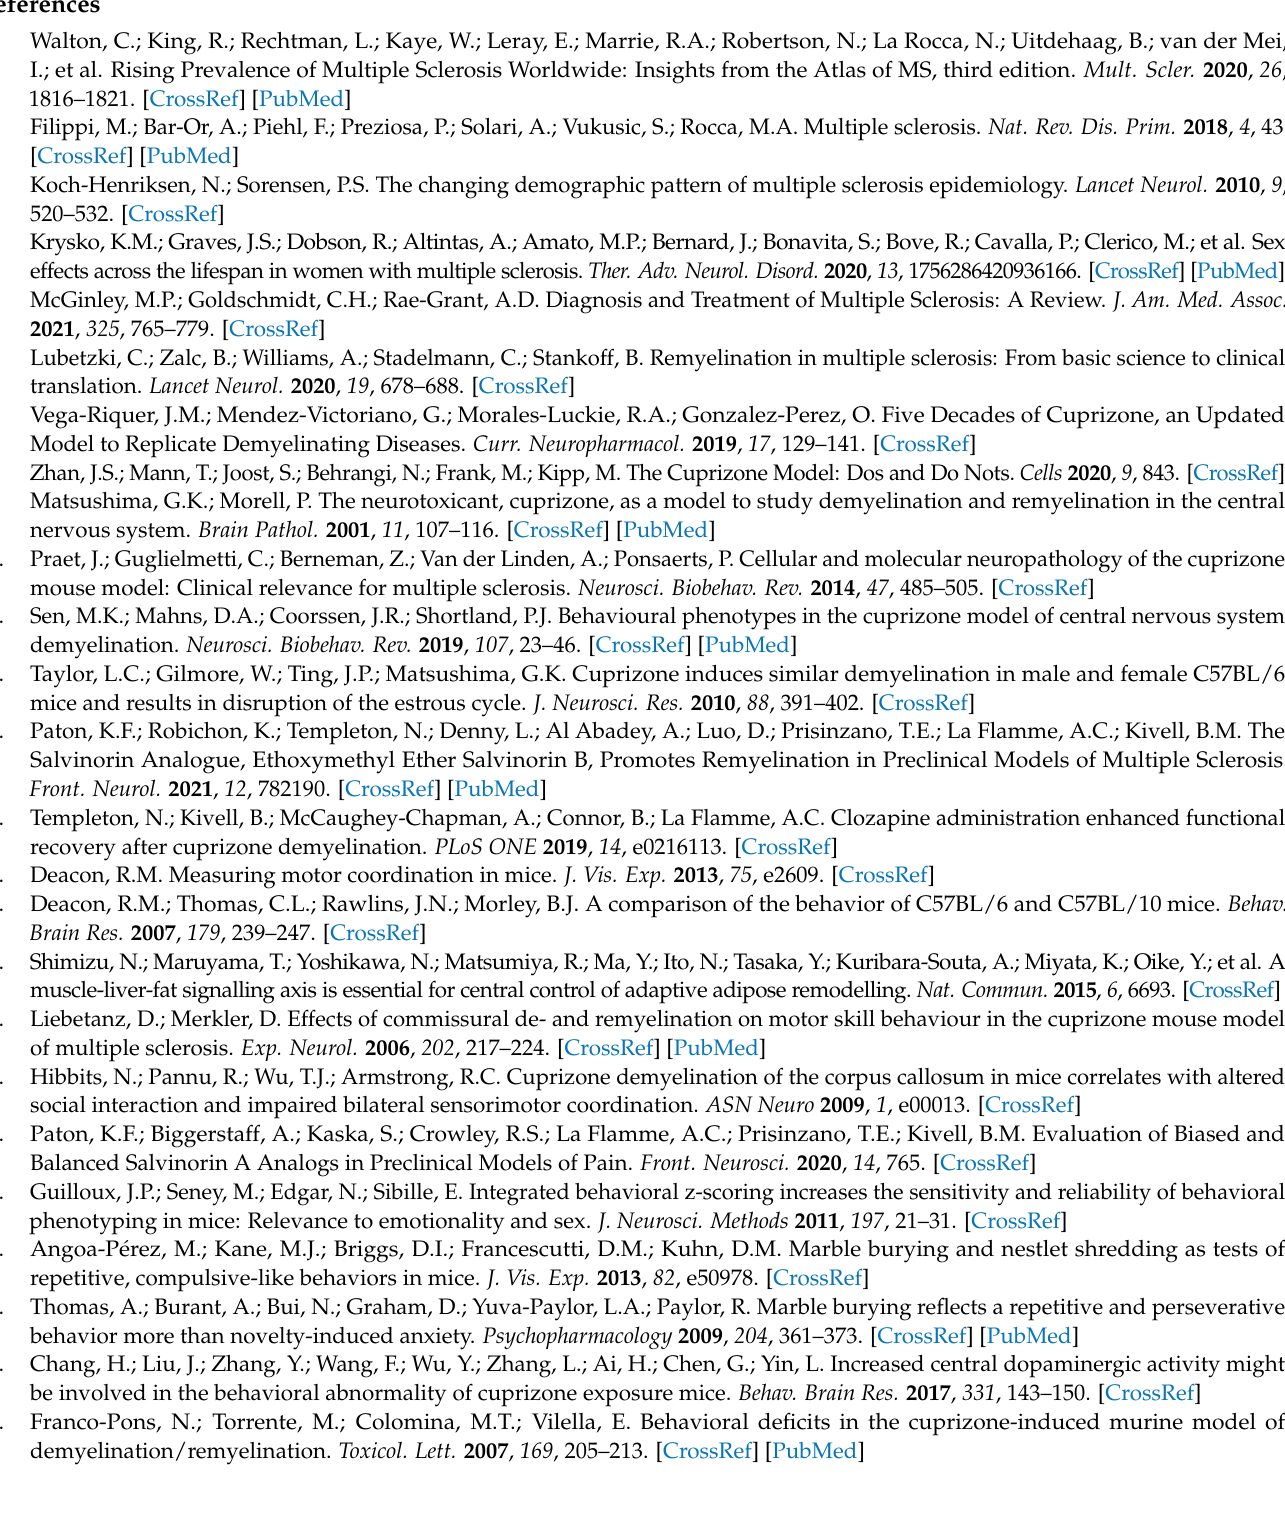
AUC, area under the curve; EAE, experimental autoimmune encephalomyelitis; MOSS, motor skill sequence; MBP, myelin basic protein; MOG, myelin oligodendrocyte glycoprotein; MS, multiple sclerosis; PLP, proteolipid